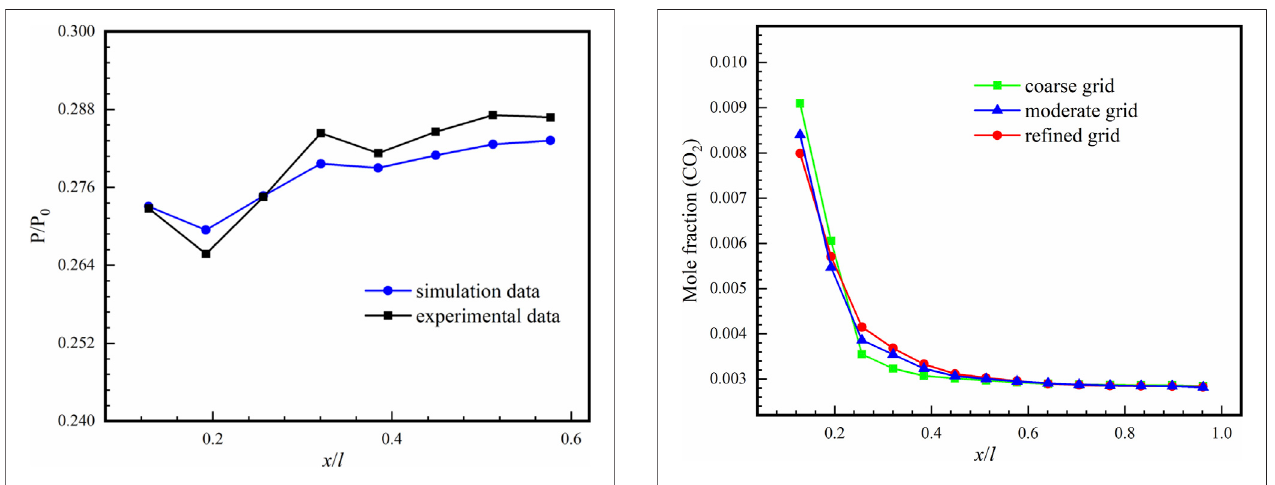
FIGURE 7 | Averaged mole fraction of CO 2 on y-z sections along the streamwise direction predicted by different grid